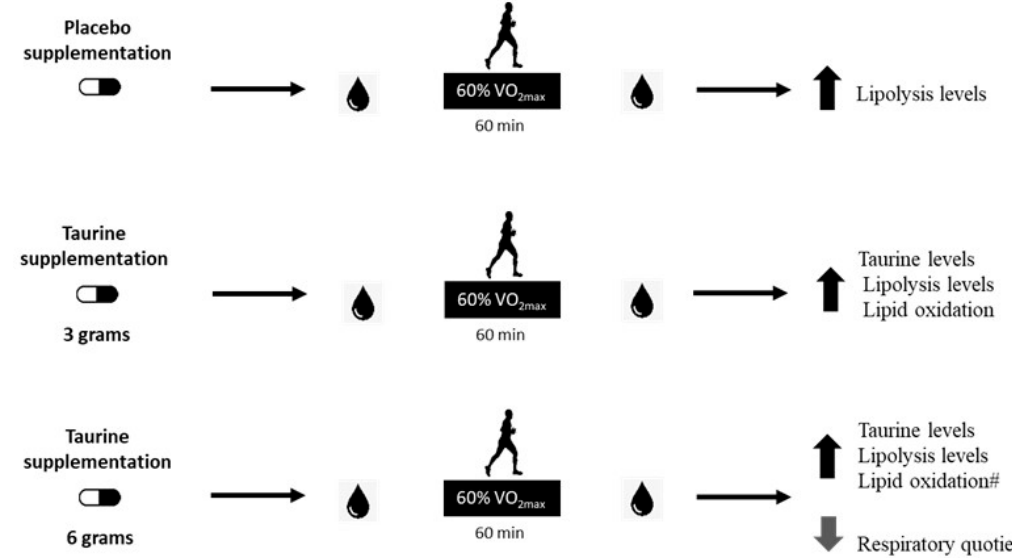
Figure 4. Main findings of the present investigation. E ff ect of the supplementation of di ff erent doses of taurine was evaluated following a bout of exercise in the fasted state, and it was observed that a moderate-intensity exercise session similarly increased lipolysis levels in all trials. Additionally, supplementation with 3 g increased taurine blood levels post-exercise when compared to placebo supplementation. The supplementation with 6 g increased taurine plasma levels and lipid oxidation, and decreased the respiratory quotient post-exercise when compared to placebo supplementation, and lipid oxidation was 27% higher than TAU 3 g (#), showing a greater impact on lipid oxidation than the 3 g in healthy young men. Table S1: Time-point of measures of oxygen uptake (VO 2 ), carbon dioxide production (VCO2), respiratory quotient (RQ) and substrate oxidation in the 10 min of the calorimetry test for all groups /